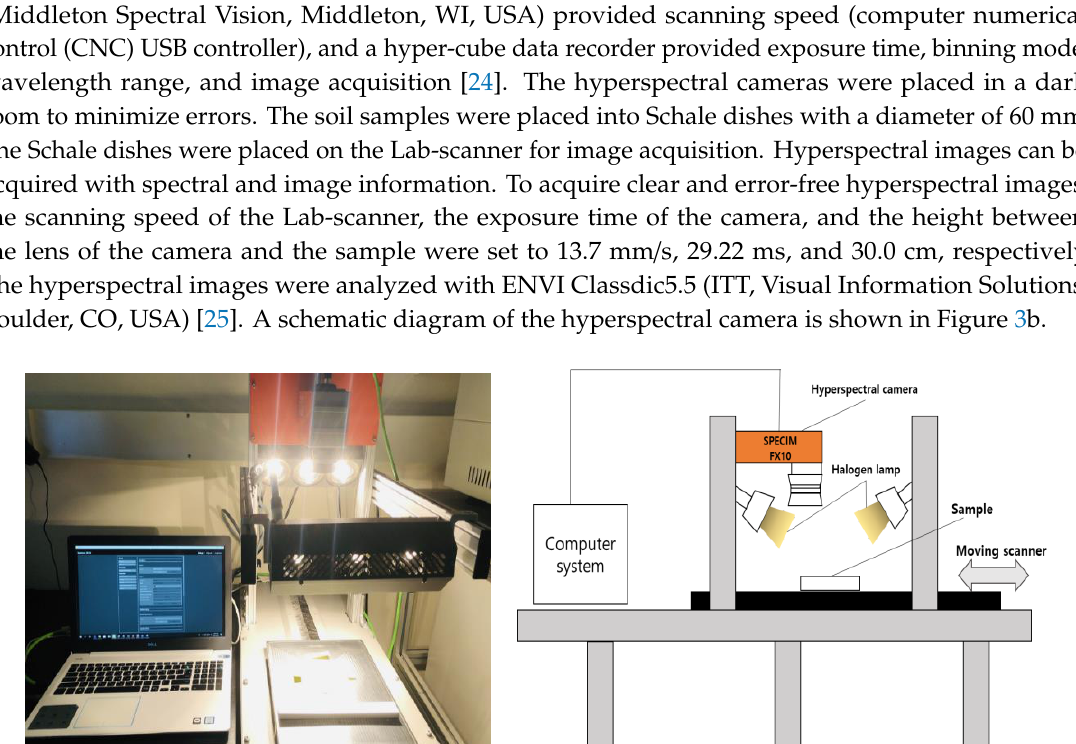
Figure 3. Hyperspectral camera system: ( a ) hyperspectral camera in the laboratory and ( b ) schematic diagram of the hyperspectral camera. Table 2. SPECIM FX10 main